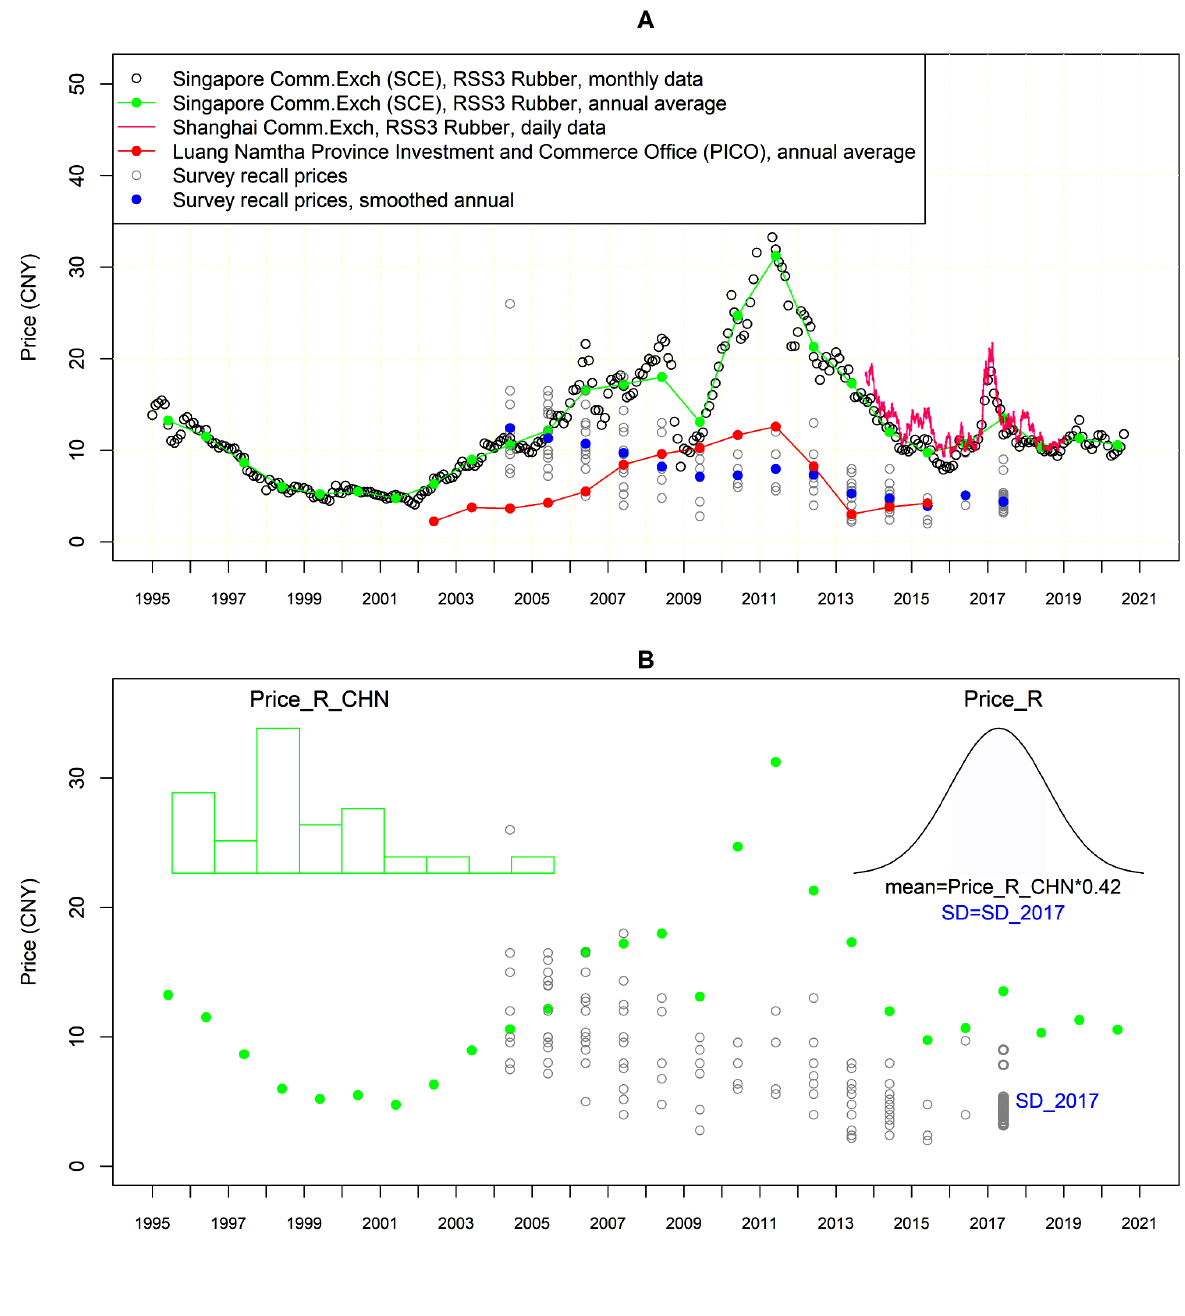
Fig. 3 . (A) Rubber prices from different sources: Singapore Commodity Exchange Asia Rubber grade RSS3 (Indexmundi 2020), Shanghai Commodity Exchange (Quandl 2019), Luang Namtha Province Investment and Commerce Office (Vongvisouk and Dwyer 2017), and recall rubber prices elicited in the survey, as well as their smoothed values. CNY = Chinese Yuan. (B) Illustration of rubber price parameterization in the Bayesian network (BN): for market price in China (Price_R_CHN), using a frequency count of annual average values; for local price (Price_R), assuming a normal distribution conditional on Price_R_CHN, with mean equal to Price_R_CHN times a conversion factor, and standard deviation (SD) equal to the standard deviation of 2017 local (survey recall)